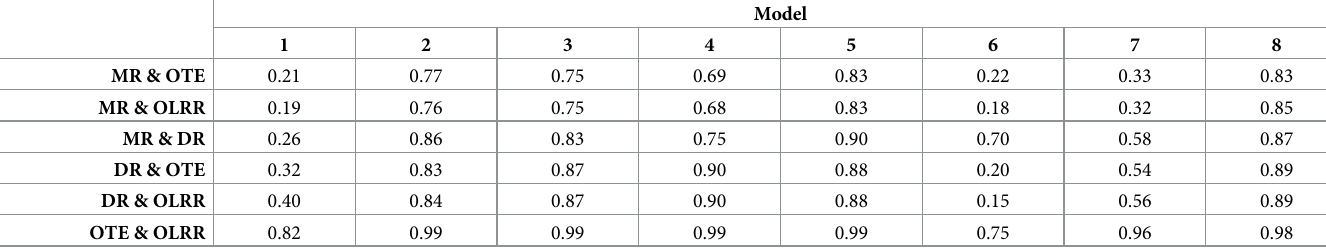
Table 4. Pair-wise correlation coefficients between PPLDs.